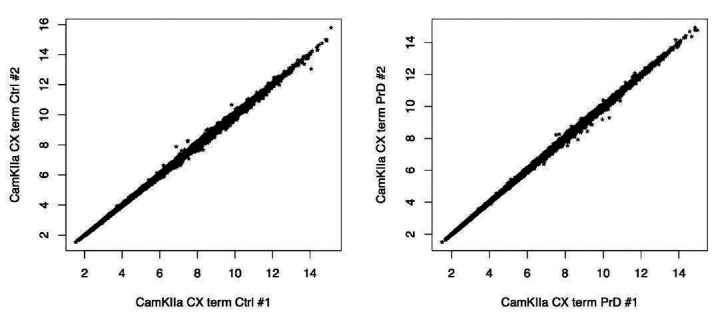
Scatterplots of samples with just two replicates per group.Both ctrl (left panel) and the PrD (right panel) terminal CamKlla cortex samples showed a high correlation of rlog transformed RPF counts between replicates.